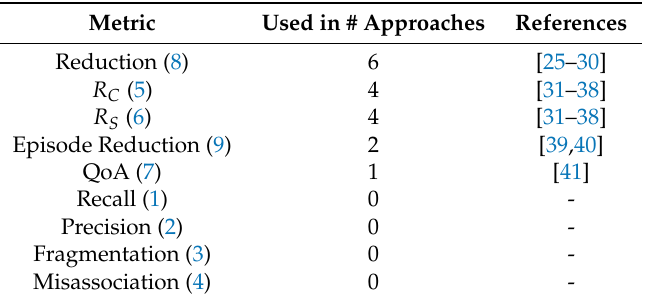
Table 2. Usage of evaluation metrics in the surveyed